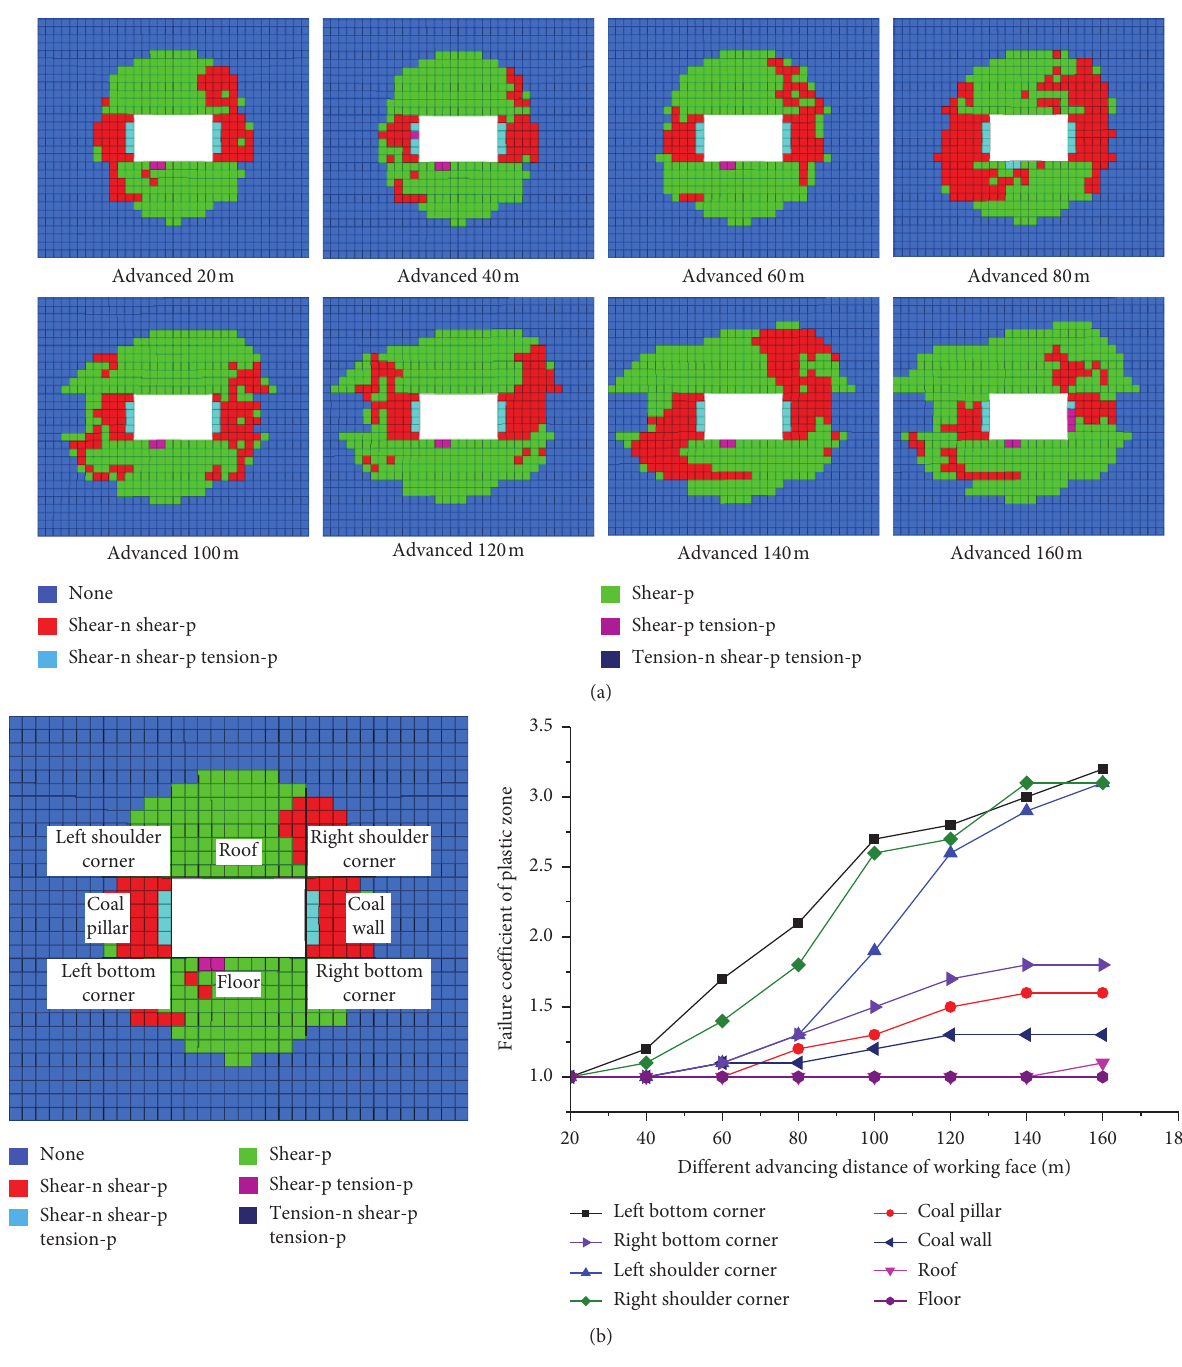
Figure 10: Evolution distribution shapes of plastic zone with advancement of the different working face. (a) Plastic failure form and (b) statistical curves of the plastic failure